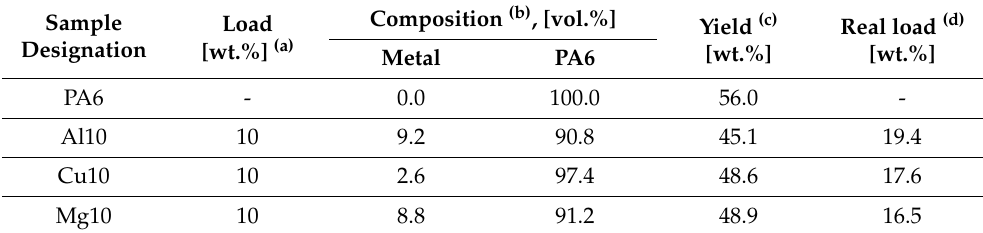
Table 1 . Designation, composition, and polymerization yields of MP samples. Table 1. Designation, composition, and polymerization yields of MP samples.